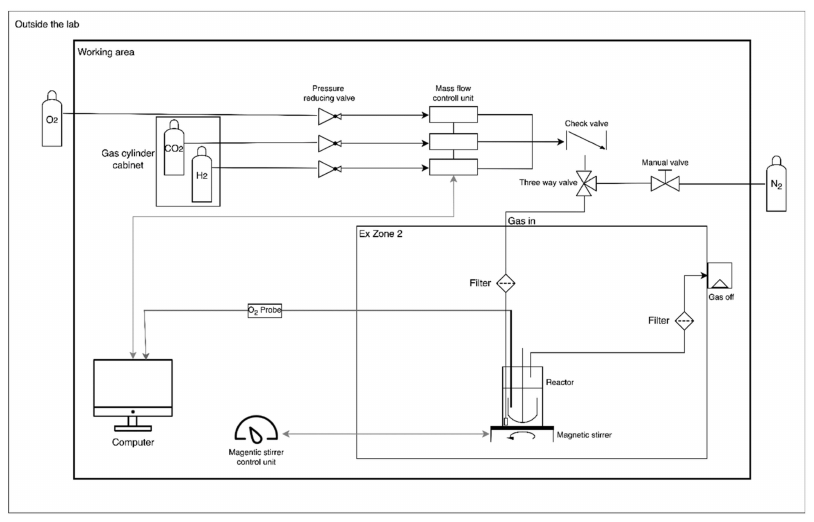
Figure 1. Scheme of gas cultivation setup. Flow diagram of installations and cultivation equipment. (Open-source program diagrams.net © 2005–2021 JGraph Ltd. was used for figure